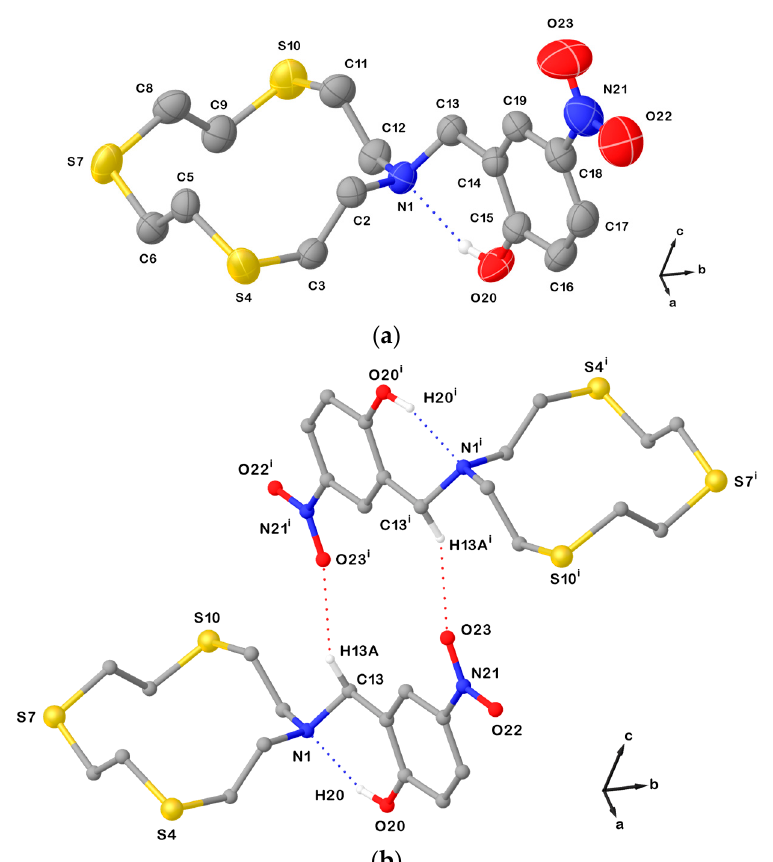
Figure 5. ( a ) View of the asymmetric unit in L21 · CHCl 3 with the atom-labelling scheme adopted. Displacement ellipsoids are drawn at 50% probability level. Hydrogen atoms and the co-crystallized CHCl 3 molecule are omitted for clarity; ( b ) H-bonded dimeric arrangement found in L21 · CHCl 3 . Only interacting hydrogen atoms are shown for clarity. N1 ··· O20 = 2.612(3); N1 ··· H20 = 1.90(3) Å; O20 − H20···N1 = 150(3) o ; C13 − O23 i = 3.354(3) Å; and symmetry operation: i = 1 − x , 2 − y , 2 − z. For selected bond lengths (Å) and angles ( o ), see Table S4 in the Supplementary Materials.